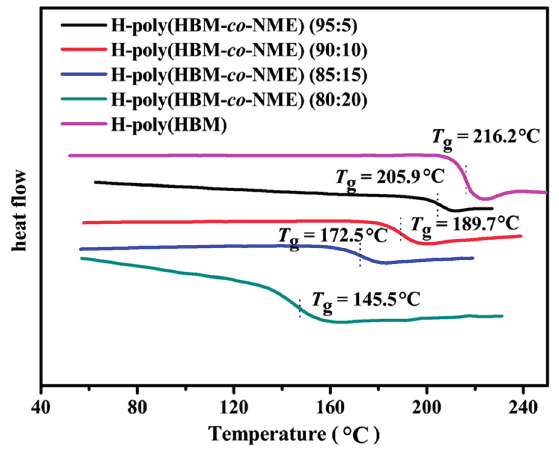
Figure A6. DSC curves of copolymers of HBM and NMA.